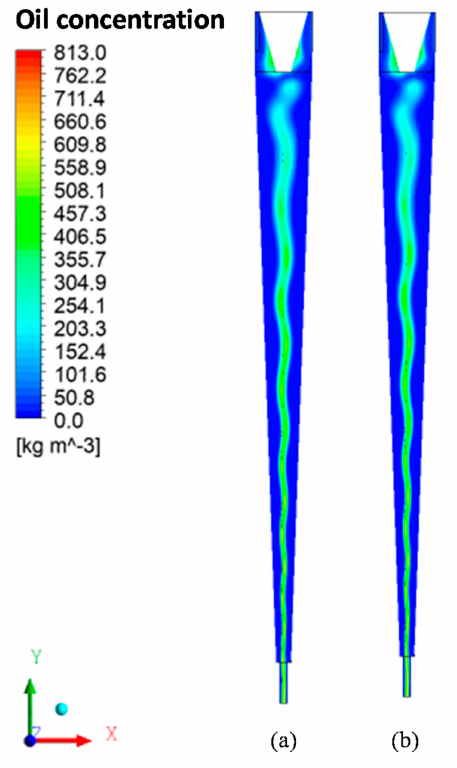
Figure 7. Oil concentration fields in the xy plane for the case f o = 5% and feed velocity of 15 m/s with ( a ) δ p = 0 mm, and ( b ) δ p = 7.82 × 10 − 2